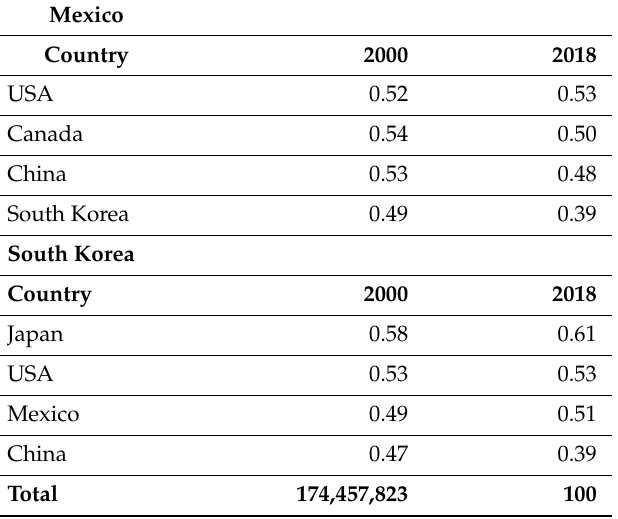
Table 9. Similarity